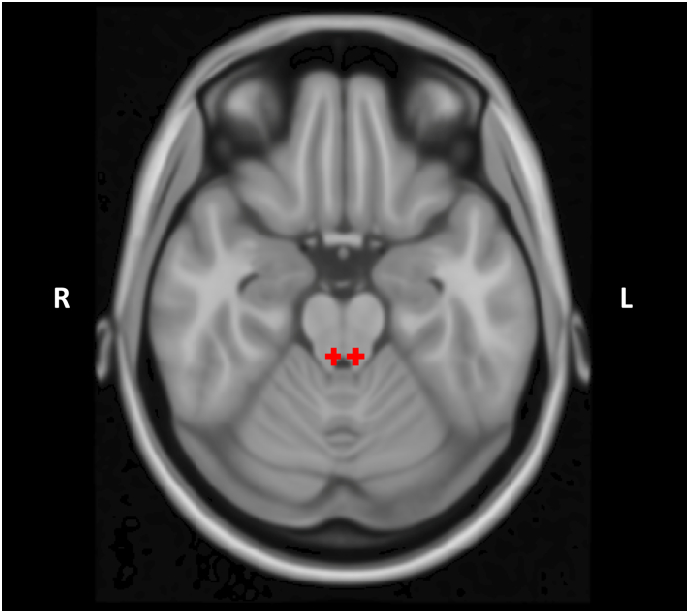
Bilateral spherical seeds of 2 mm each placed in the locus coeruleus.